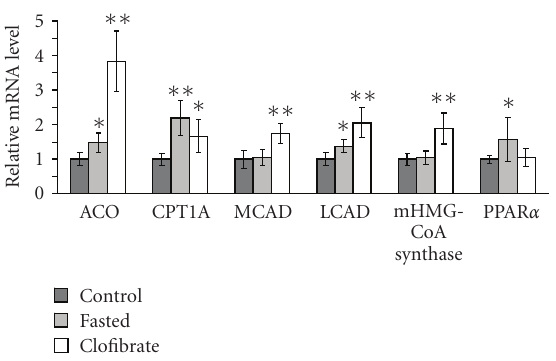
Figure 2: E ff ect of fasting or clofibrate treatment on mRNA concentration of acyl-CoA oxidase (ACO), carnitine palmitoyl- transferases (CPT)-1A, medium chain acyl-CoA dehydrogenase (MCAD), long chain acyl-CoA dehydrogenase (LCAD), mitochon- drial 3-hydroxy-3-methylglutaryl-(mHMG)-CoA synthase, and peroxisome proliferator-activated receptor (PPAR)- α in the liver of rats. All rats obtained a standard basal diet for 4 days. Animals of the fasting group were fasted 36hours before killing. Rats of the clofibrate group were treated orally with 250 mg/kg of clofibrate per day. Values are means ± SD ( n = 9). Symbols indicate significant di ff erence from control rats ( ∗ P < . 05, ∗∗ P < .